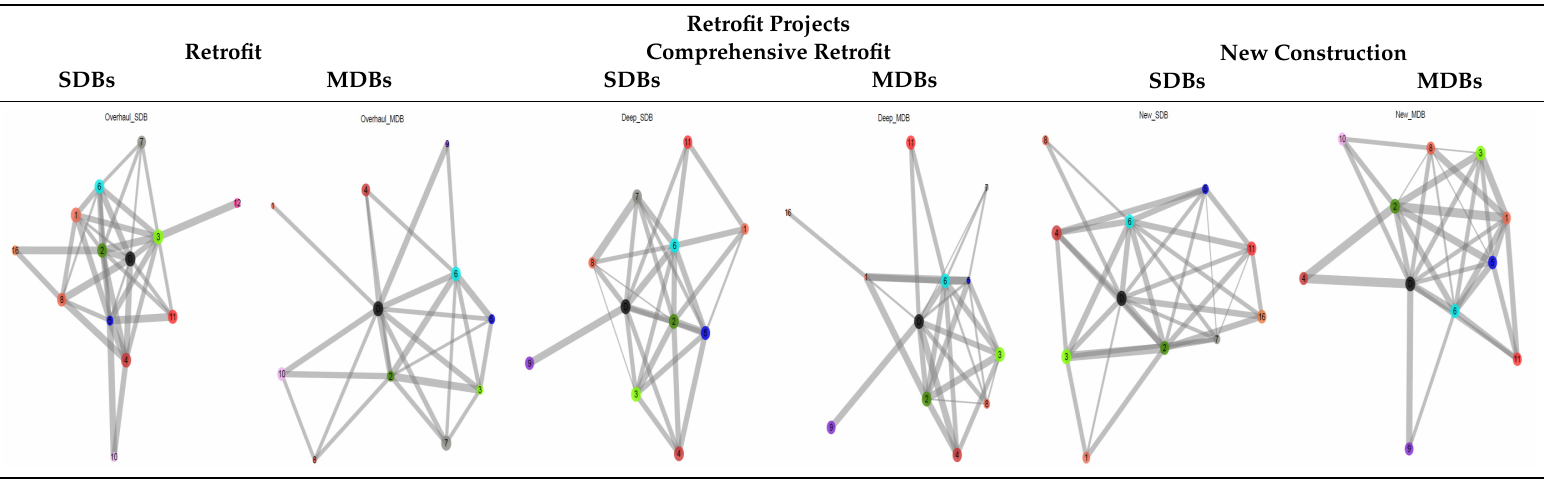
Table 5. Stakeholder level of power and interaction in the technology selection, classified according to building typologies and project types in Spain